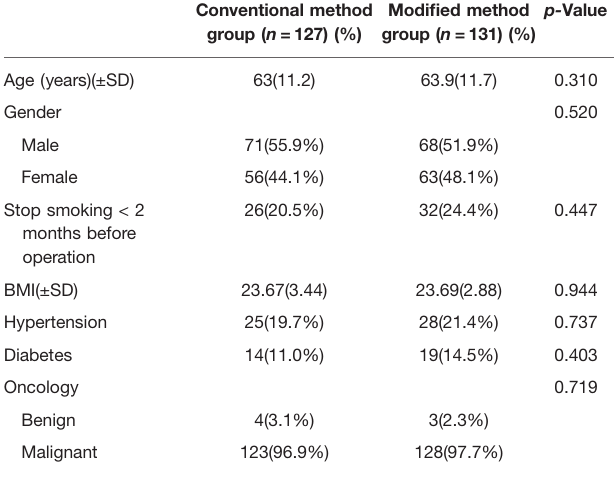
TABLE 1 | Baseline characteristics.